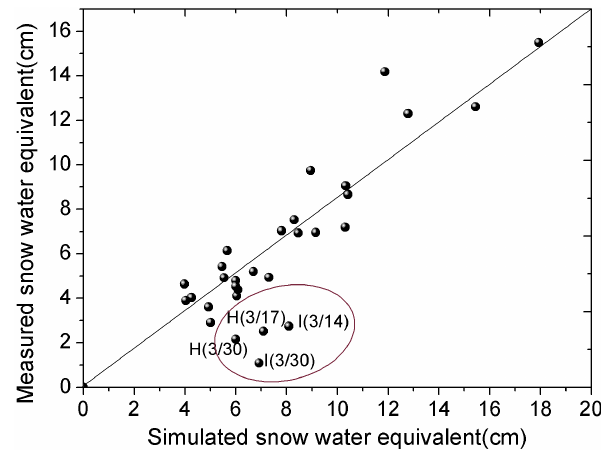
Fig. 4. Validation of the simulated snow-water equivalent us- ing measurements at sampling regions in the Binggou watershed (H(3/30) represents the measured snow depth in the H region on 30 March, and so